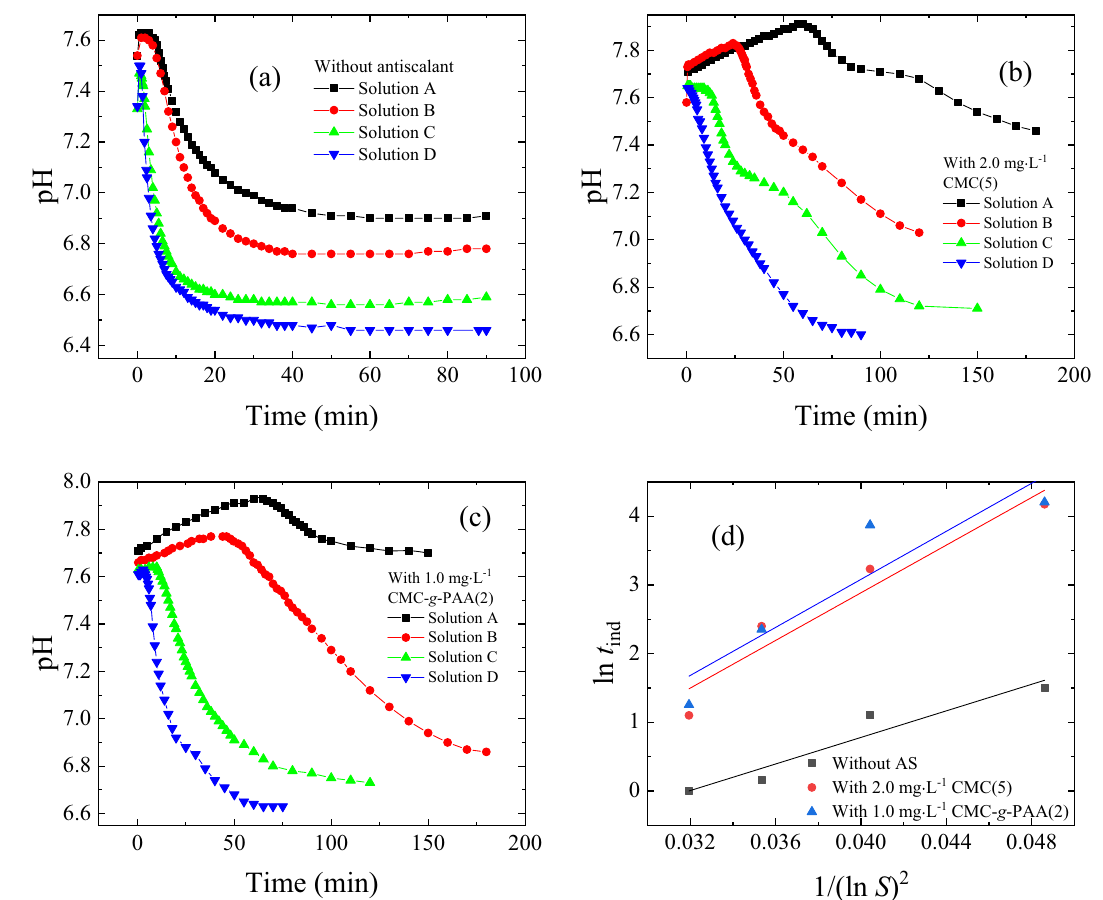
Figure 8. pH changes in the CaCO 3 crystal growth process using four calcium carbonate solutions with various supersaturation ratios ( a ) in the absence of antiscalants, ( b ) in the presence of 2.0 mg L −1 CMC(5) and ( c ) in the presence of 1.0 mg L −1 CMC- g -PAA(2); ( d ) Relation between ln t ind and 1/(ln S ) 2 without antiscalants, with 2.0 mg L −1 CMC(5) and with 1.0 mg L −1 CMC- g -PAA(2),